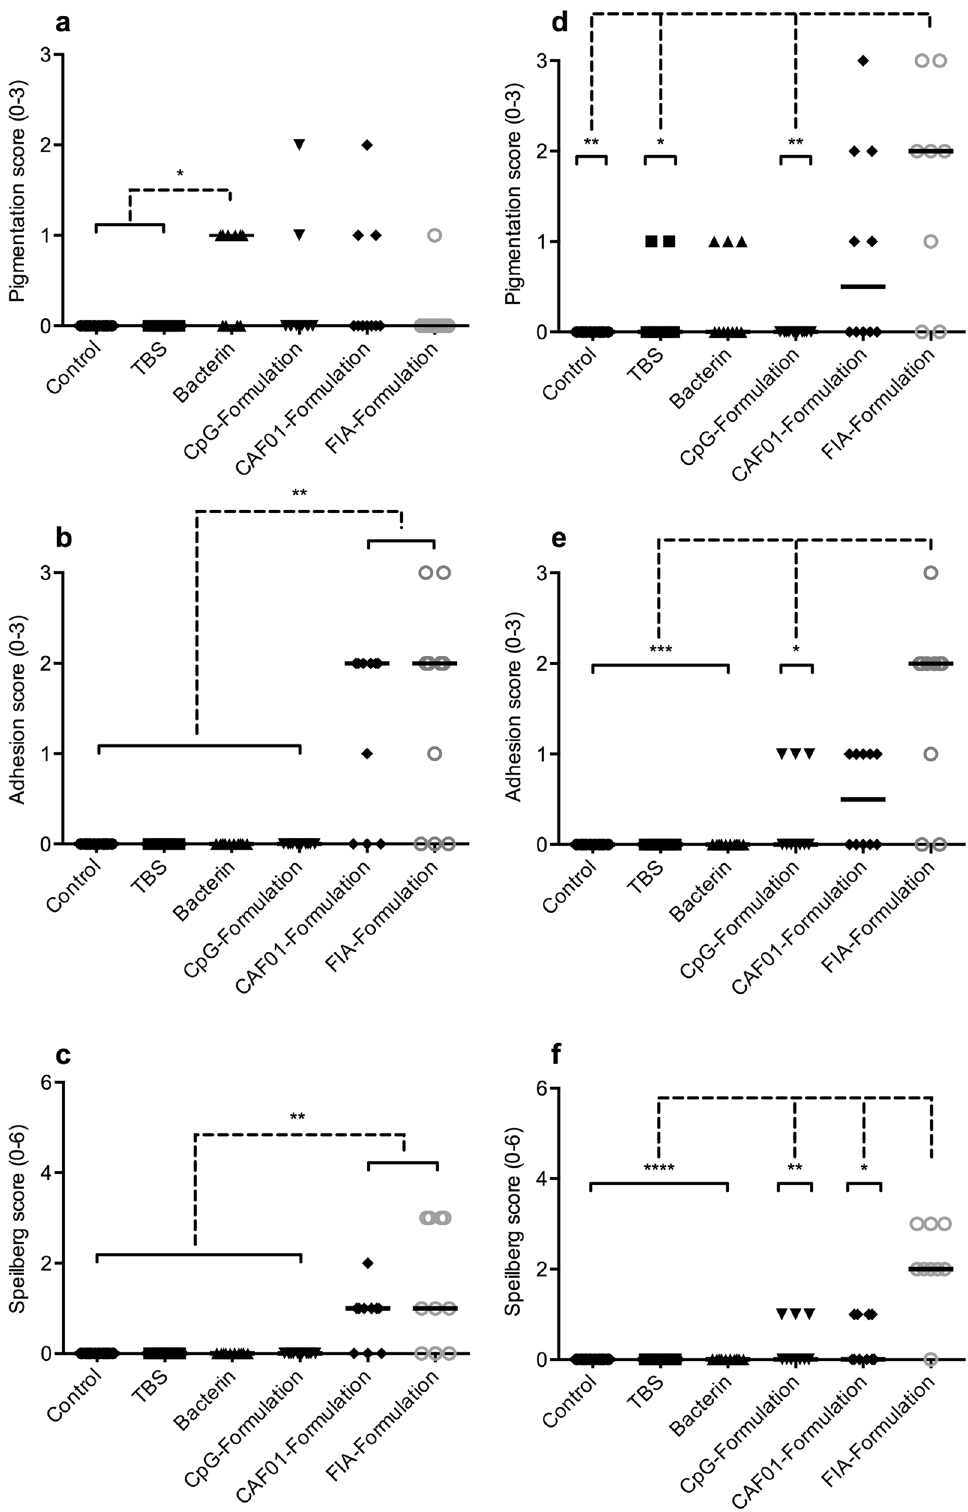
Figure 2. Results from post-mortem gross pathological scoring performed three ( a – c ) and ten ( d – f ) weeks post vaccination. Scoring and statistical methods are described in the materials and methods section. Scores are presented as dot-plots with median scores indicated. Asterisks show statistically significant differences between groups and denote: * P < 0.05, ** P < 0.01, *** P < 0.001 and **** P <